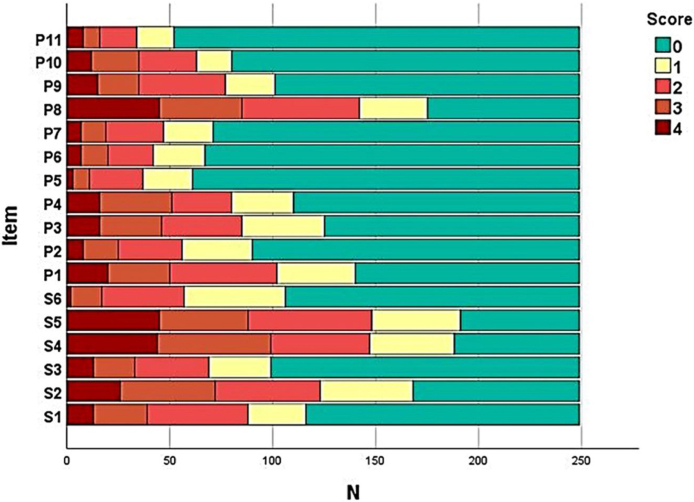
Diagram of frequency of response to items in the SK-17 (n = 217).